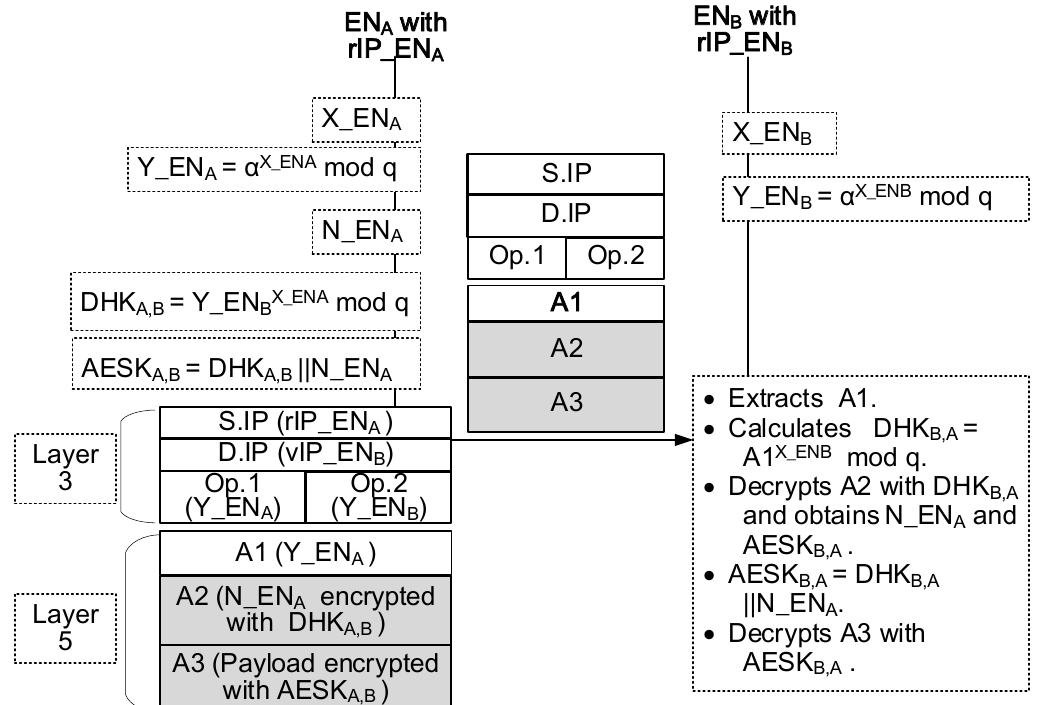
Figure 4. 112-bit nonce, 16-bit DH key and 128-bit one-time AES